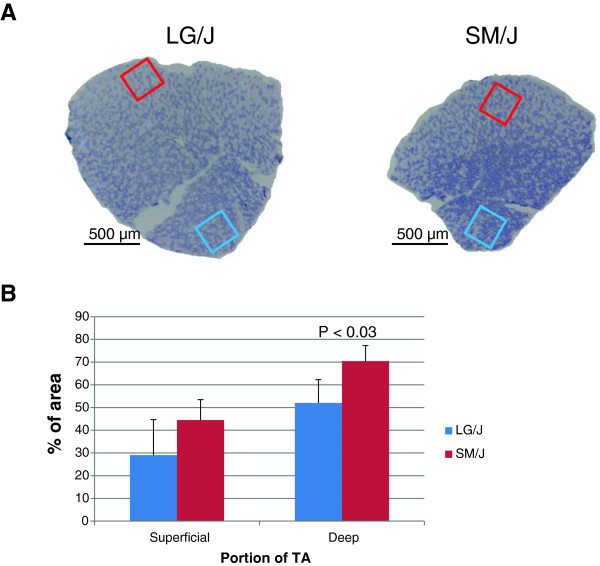
NADH tetrazolium reductase staining in TA muscle. Representative areas of the superficial (panel A, red box) and deep (blue box) portion of the muscle were quantified for the staining intensity (darker stain corresponds to a higher oxidative capacity). Panel B; mean and SD (n=4 per strain) of the area occupied by the dark stained, oxidative, fibers.